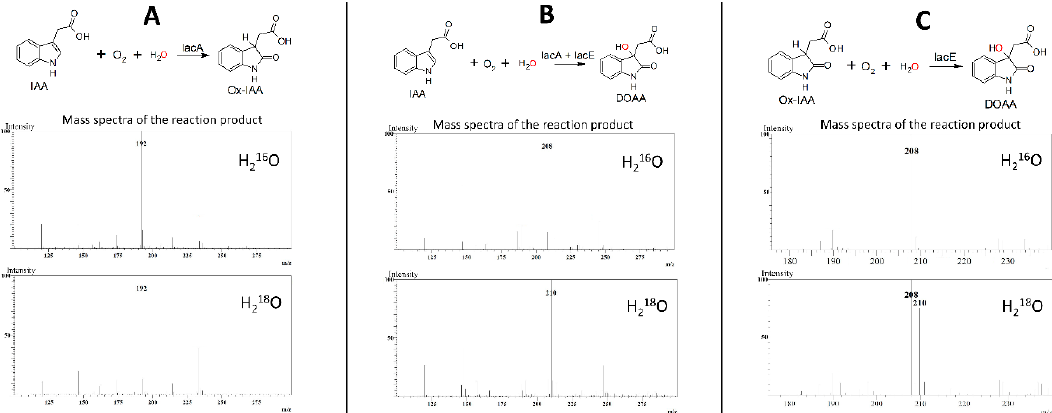
Figure 6 . Mass spectra of Ox-IAA and DOAA obtained by using E. coli cells expressing IacA and IacE in H 216 O environment and H 218 O environment. ( A )—Ox-IAA from IAA + IacA, ( B )—DOAA from IAA + IacAE, ( C )—DOAA from Ox-IAA + IacE. All mass spectra that are presented were recorded in positive ionization mode.